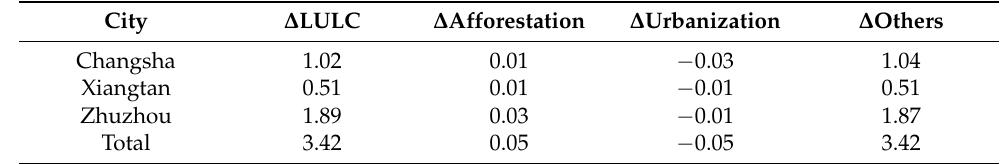
Table 3. The effects of land-use changes on the total production (T gC) in the CZT urban agglom- eration from 2000 to 2015. ∆ LUCC, the effect of all land-use changes; ∆ Afforestation, the effect of nonforest land changes to forest land; ∆ Urbanization, the effect of nonconstruction land changes to construction land; ∆ Others, the effect of other land-use changes. City ∆ LULC ∆ Afforestation ∆ Urbanization ∆ Others